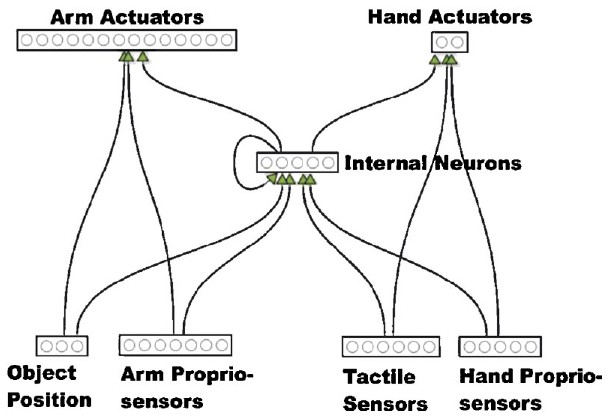
Figure3. Thearchitectureoftheneuralcontrollers .Arrowsindicatedblocks of fully connected neurons. Internal and hand actuators neurons are also provided with a bias.